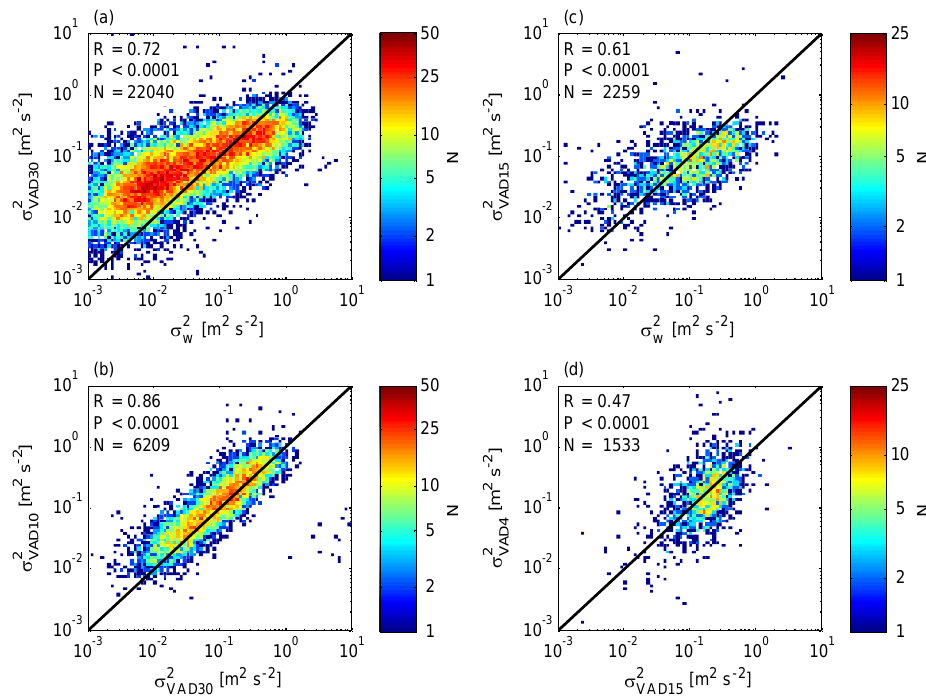
Figure 3. Frequency plots of (a) σ 2 vs. σ 2 w for 30 ◦ elevation angle VAD at Limassol, (b) σ 2 VAD from 30 ◦ elevation angle VAD at Limassol, (c) σ 2 vs. σ 2 w for 15 ◦ elevation angle VAD at Loviisa and (d) σ 2 VAD VAD vs. σ 2 from 15 ◦ elevation angle VAD at Loviisa. Only VAD measurements for radius <500m are included. The σ 2 υ contribution (cf. VAD Eq. 6) has been subtracted from σ 2 w . Correlation coefficient for logarithmic data and 1 : 1 line are included in all plots.